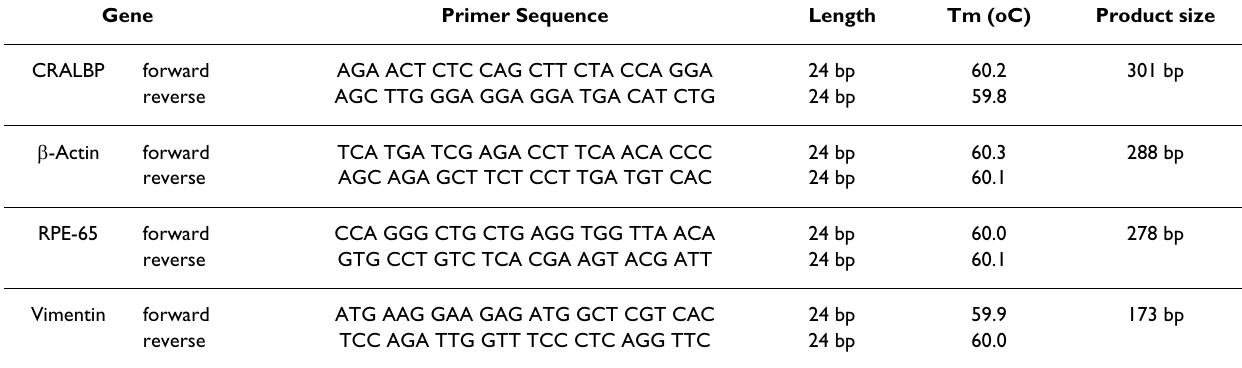
Table 1: Primers used for the reverse transcriptase PCR Gene Primer Sequence